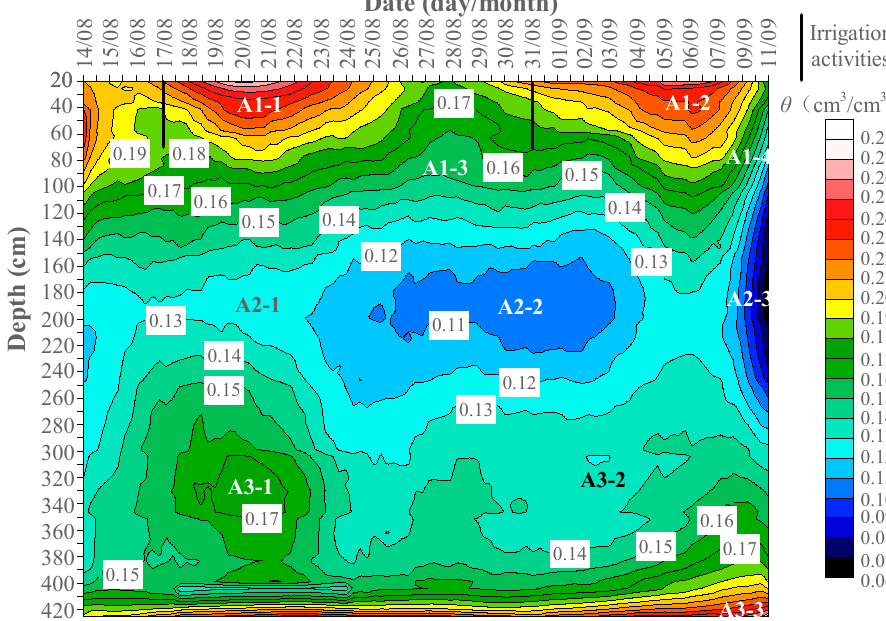
Figure 7. The soil moisture isogram of time and depth at point 4 with the crop of edamame.